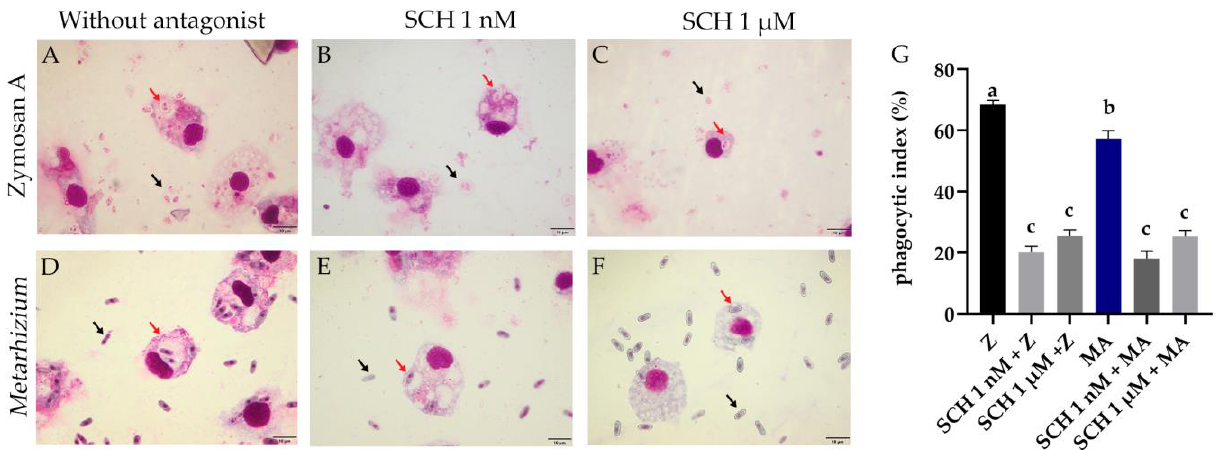
Figure 1. ( A – F ) Rhipicephalus microplus hemocytes on slides exposed to Metarhizium anisopliae (MA) or Zymosan (Z) for two hours with or without previous incubation of SCH 23390 dopamine receptor antagonist at 1 nM or 1µM for one hour. ( A ) Z; ( B ) SCH 1 nM + Z; ( C ) SCH 1 µM + MA; ( D ) MA; ( E ) SCH 1 nM + MA; ( F ) SCH 1 µM + MA. Black arrows indicate Metarhizium conidia or Zymosan that were not phagocytosed. Red arrows indicate conidia or Zymosan phagocytosed. The scale bar rep- resents 10 μm. ( G ) Phagocytic index (%) of R. microplus hemocytes after incubation with M. anisopliae conidia or Saccharomyces cerevisiae (Zymosan A) with or without SCH 23390. Data were analyzed by one-way ANOVA and the Tukey ’s test ( p < 0.05). Different letters differ statistically. Z: cells ex- posed to Zymosan A alone; SCH 1 nM + Z: cells exposed to the antagonist at 1 nM followed by Zymosan A; SCH 1 µM + Z: cells exposed to the antagonist at 1 µM followed by Zymosan A; MA: cells exposed to M. anisopliae alone; SCH 1 nM + MA: cells exposed to the antagonist at 1 nM fol- lowed by M. anisopliae ; SCH 1 µM + MA: cells exposed to the antagonist at 1 µM followed by M. anisopliae .